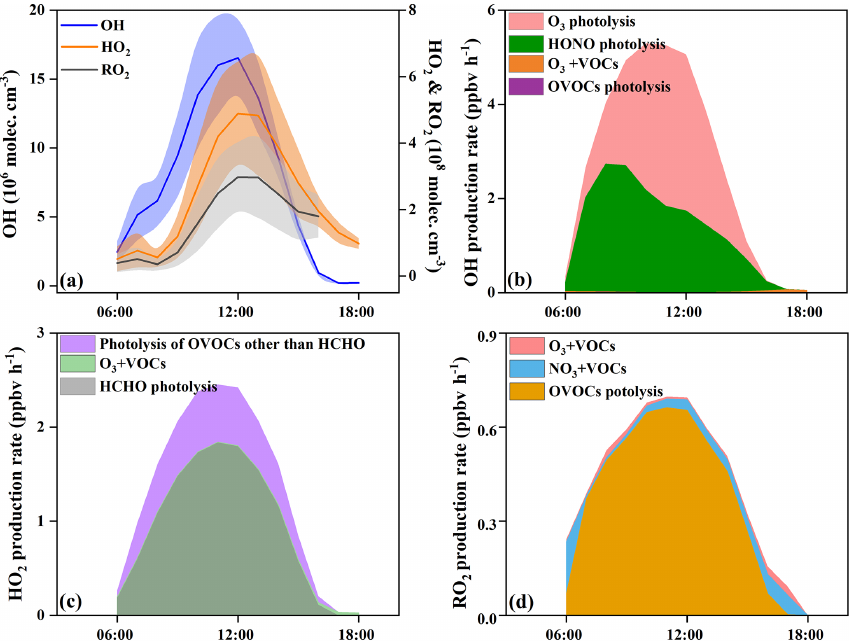
Figure 6. Model-simulated daytime average diurnal variations in (a) OH, HO 2 , and RO 2 concentrations and average primary production rates of (b) OH, (c) HO 2 , and (d) RO 2 during 20–29 September 2019 in